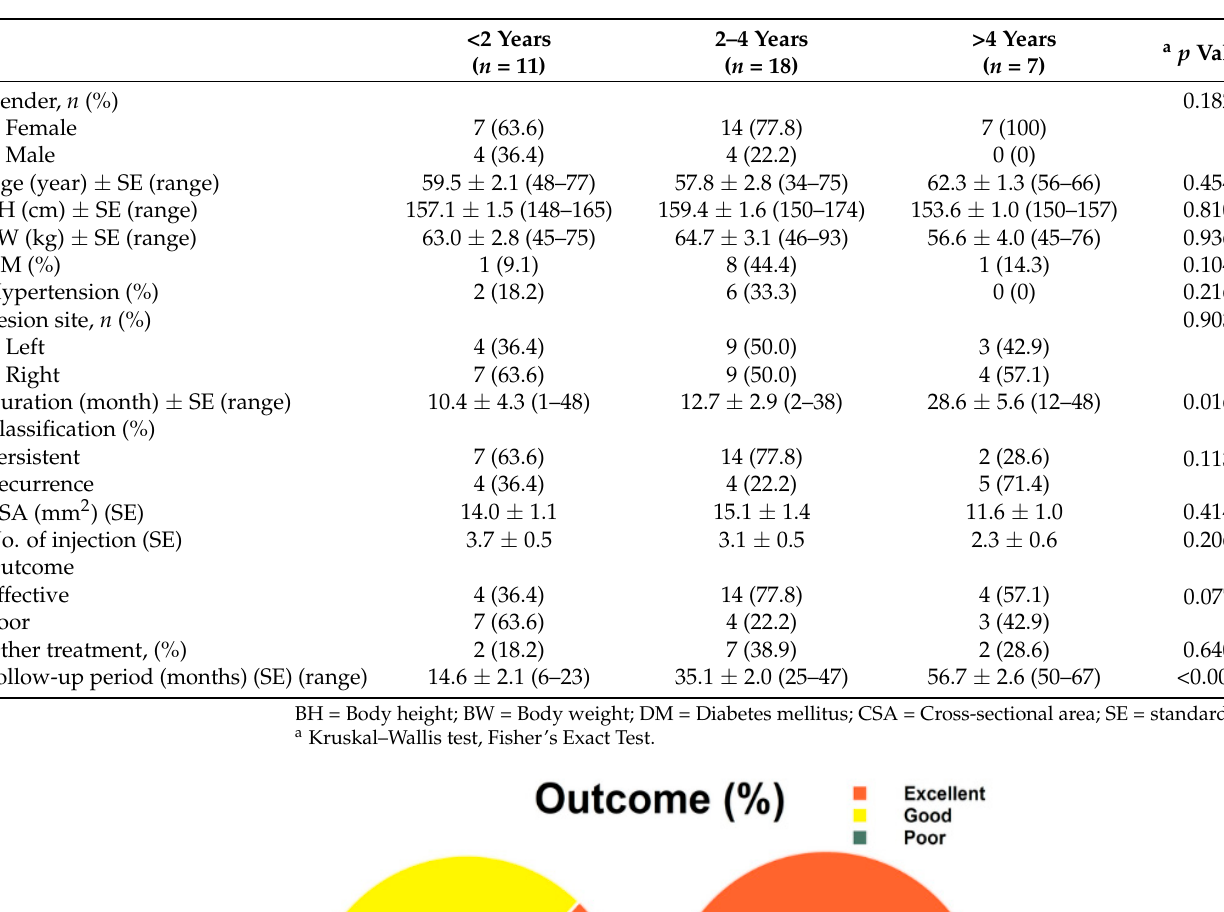
Table 3. Demographic information of all patients with different follow-up periods.